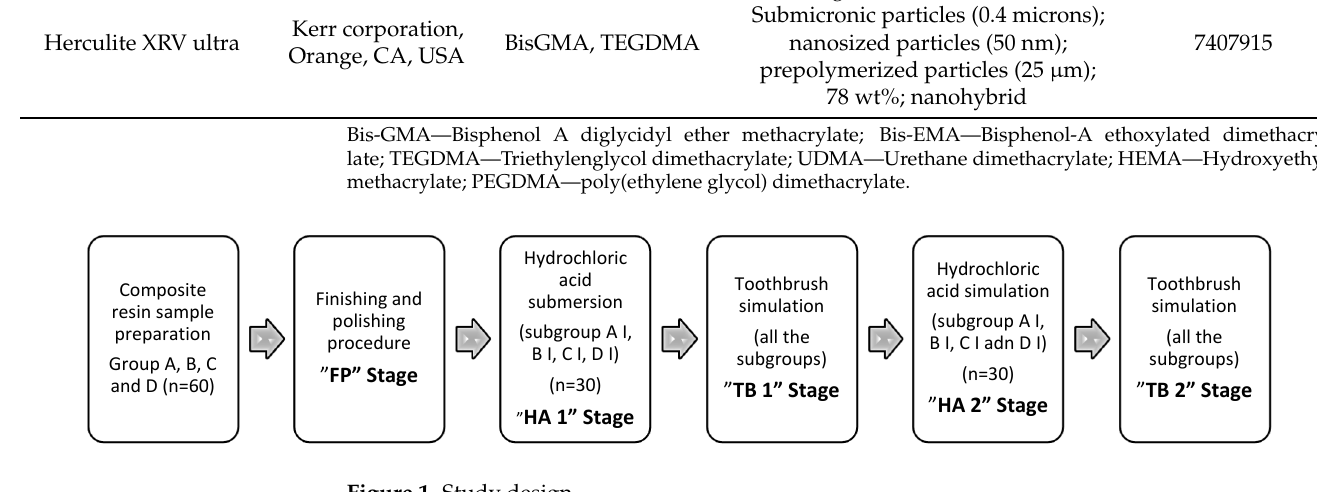
Figure 1. Study Figure 1. Study design.